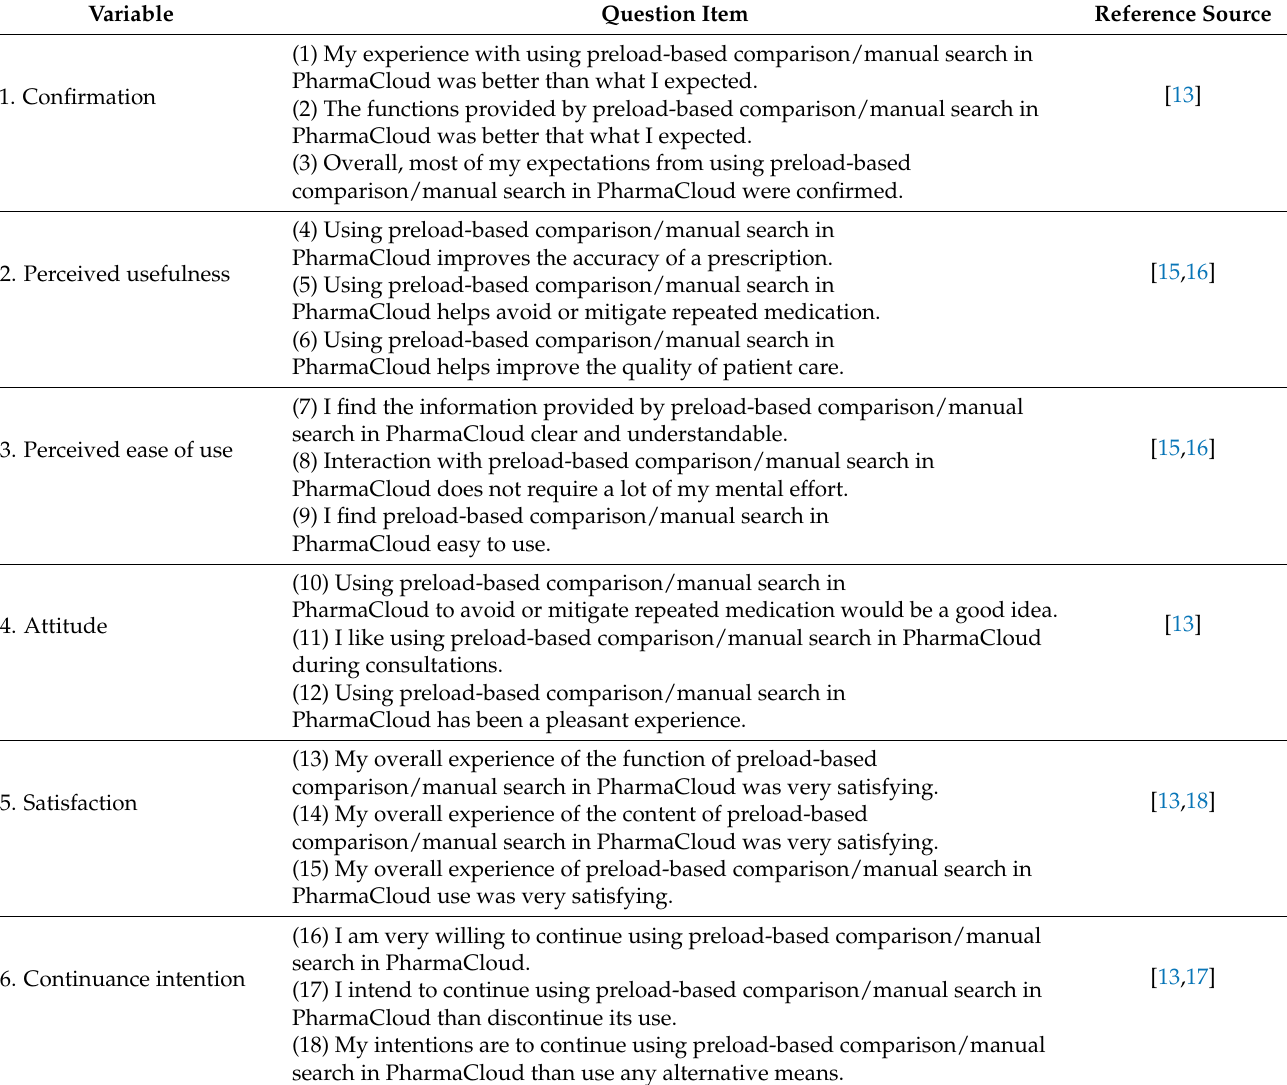
Table 1. Question items and their reference